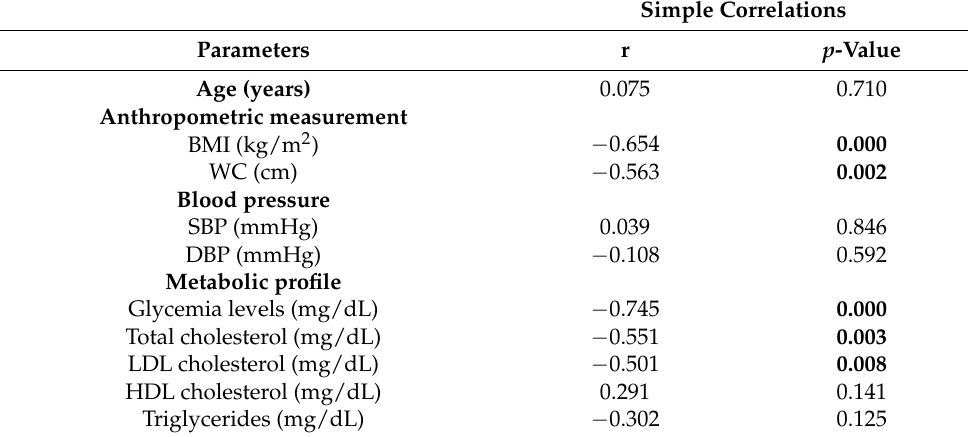
Table 6. Correlations of chronotype score with study parameters adjusted for sex in the control group.